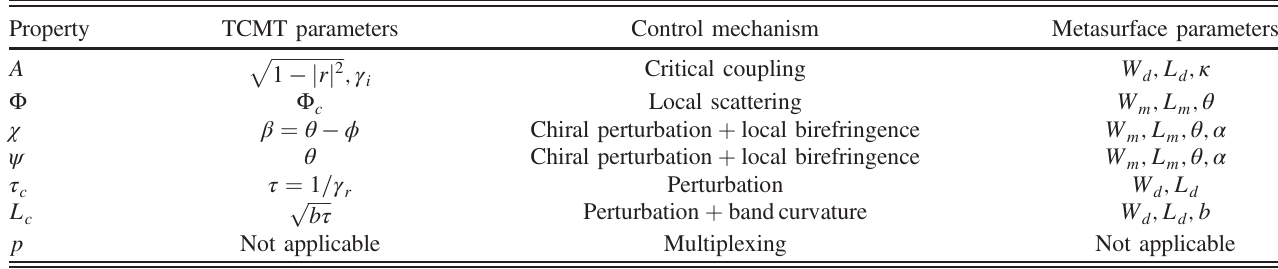
TABLE I. Complete control of thermal